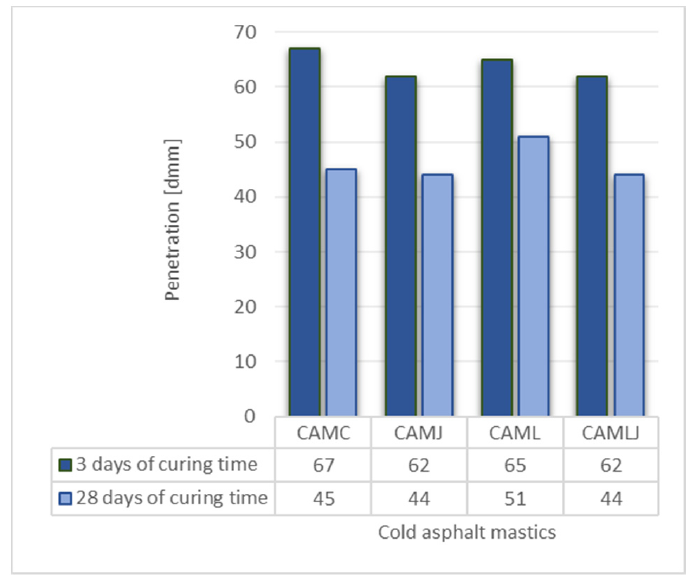
Figure 7. Penetration values for cold mastics subjected to different curing time. Figure 8 shows the R&B values of the hot asphalt mastics; it can be observed that all the hot asphalt solutions have higher R&B value than B5070. In particular, HAMJ, HAML, and HAMLJ have 24%, 7%, and 35% higher R&B value than that of B5070. Among all, HAMLJ showed the highest R&B value, equal to 62 ◦ C.